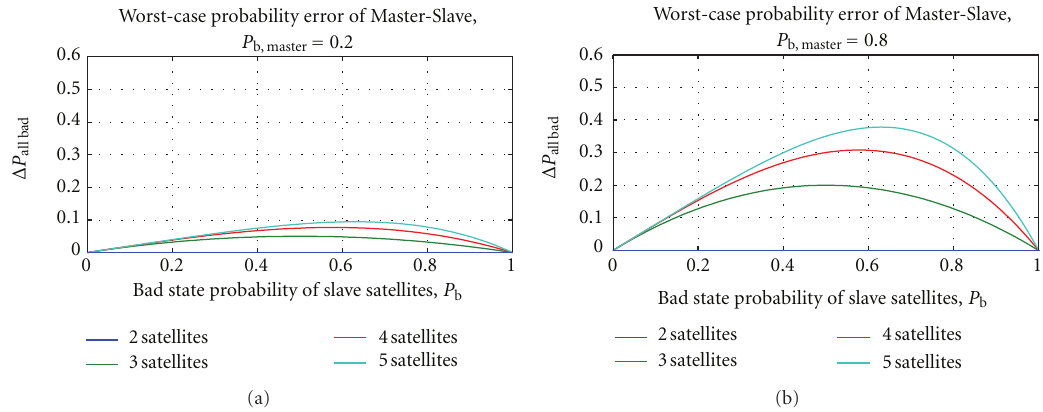
Figure 15: Worst-case probability error of the Master-Slave approach (constellations from Figure 13) with dependency on the bad state probability of the slave satellites, the number of satellites, and the master probability P b,Master = 0 . 2 (a) and P b,Master = 0 . 8 (b). A low bad state probability of the master ( (cid:2) = high elevation) is